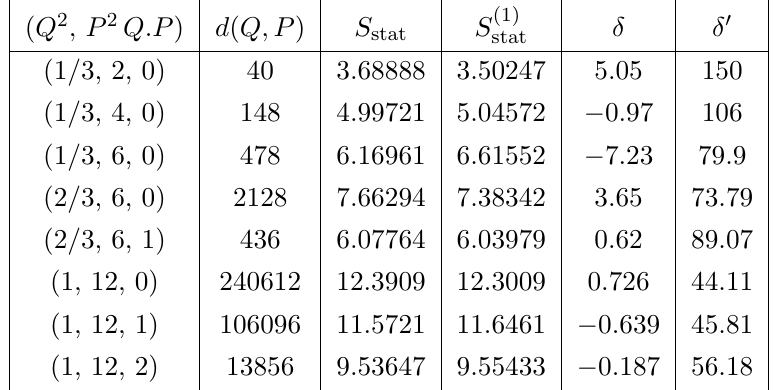
Table 12 . Comparison of the statistical entropy and statistical entropy at one loop for 6A orbifold.